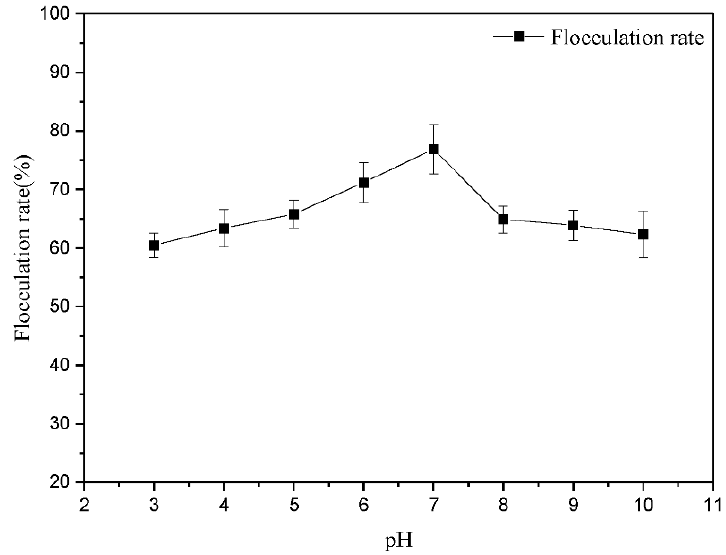
Figure 9. The effects of pH on the FS stability. Error bars show standard errors among triplicate observations.